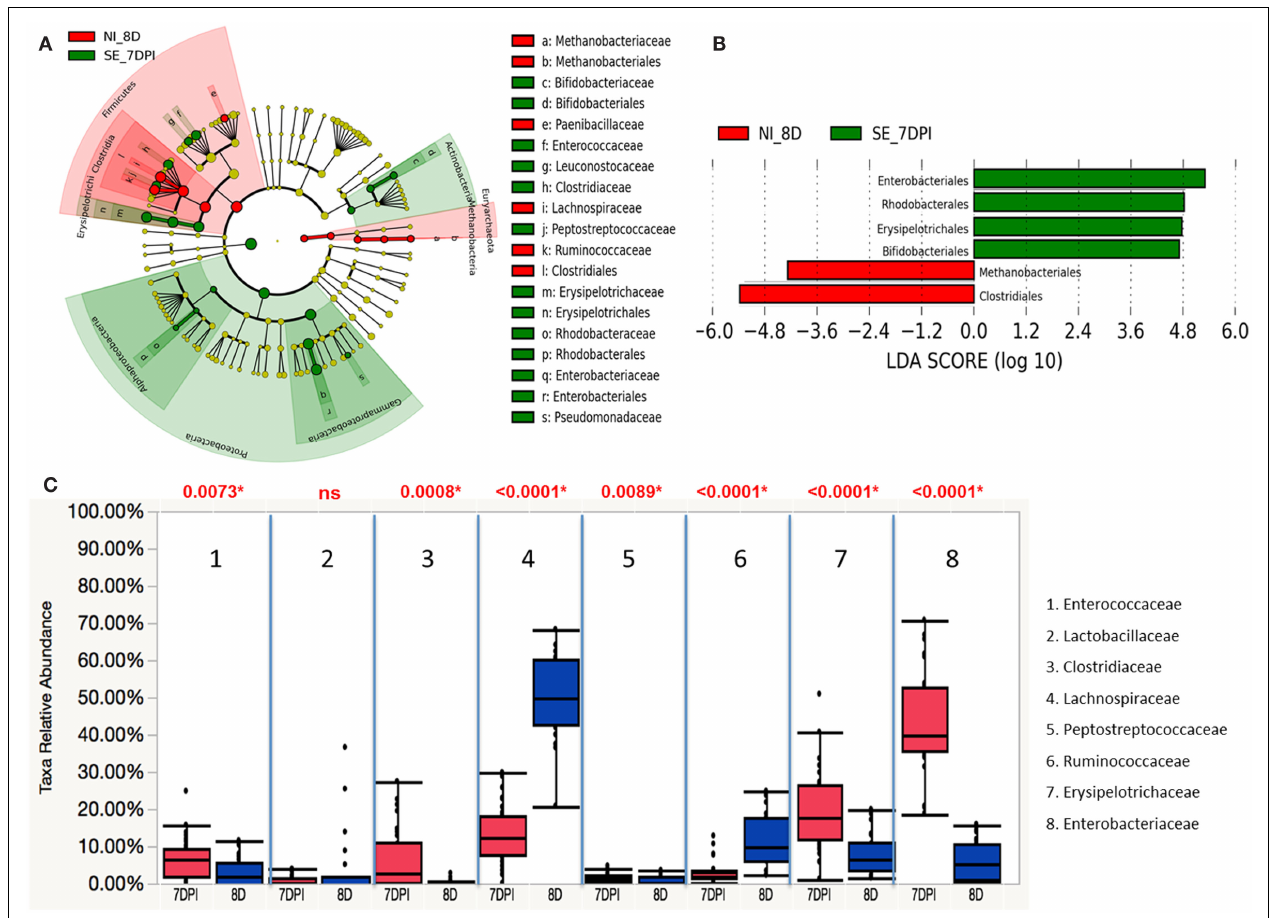
FIGURE 12 | Different abundances of cecal microbial communities between infected and non-infected group at 7DPI. (A) Taxonomic cladogram generated from LefSe analysis showing significant difference in microbiota profile of non-infected (red) and S. Enteritidis-infected (green) at 7DPI . (B) Differently abundant taxa detected with cut-off value of linear discriminant analysis (LDA) score > 2.0. Non-infected enriched taxa are indicated with negative LDA score (red) and taxa enriched in S. Enteritidis-infected have positive LDA score (green). (C) Comparison of relative abundance levels of cecal microbiota at family level in treatment group was evaluated. The boxplot shows the quartiles above and below the median with dark line at center of the box denoting median, black dots showing the outlier. Abbreviation: NI_8D, non-infected chicks at 8 days old; SE_7DPI, S. Enteritidis-infected chicks at 7 days post